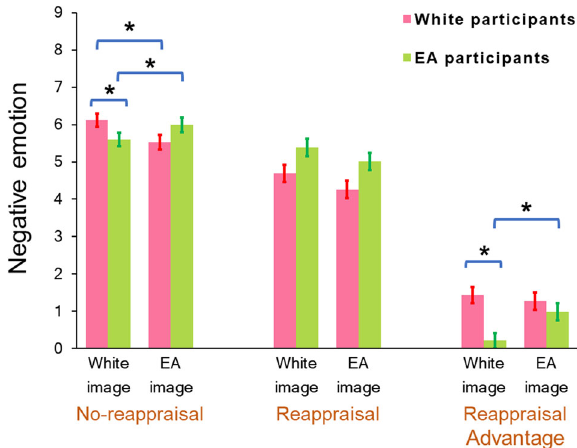
Fig. 2 The two-way interaction on ratings of negative emotion in the no- reappraisal block and the two-way interaction on ratings of “ reappraisal advantage ” . The “ reappraisal advantage ” denotes the negative emotion rating difference between no-reappraisal and reappraisal blocks. The fi gure also depicts the results of negative emotion rating experience in the reappraisal block. * p < 0.05. Error bars represent ±